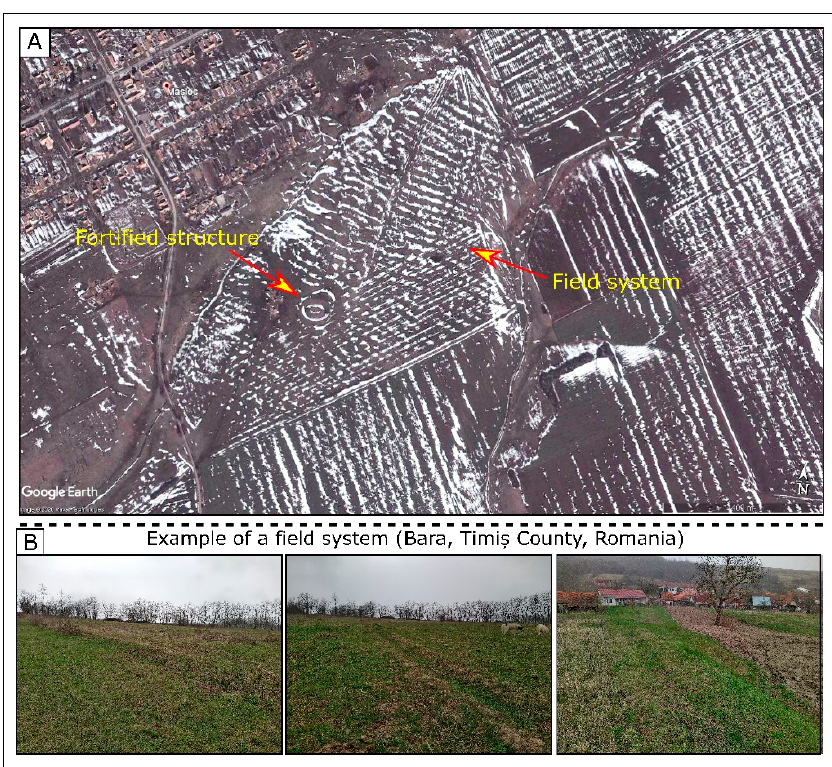
Figure 12. A . Google Earth satellite image 04 March 2012 (brightness added). The field system is easily observed as the sedimentation of snow follows the direction of the parallel stripes; B . Example of contemporary field system from Bara village, Timi ș County, Romania.